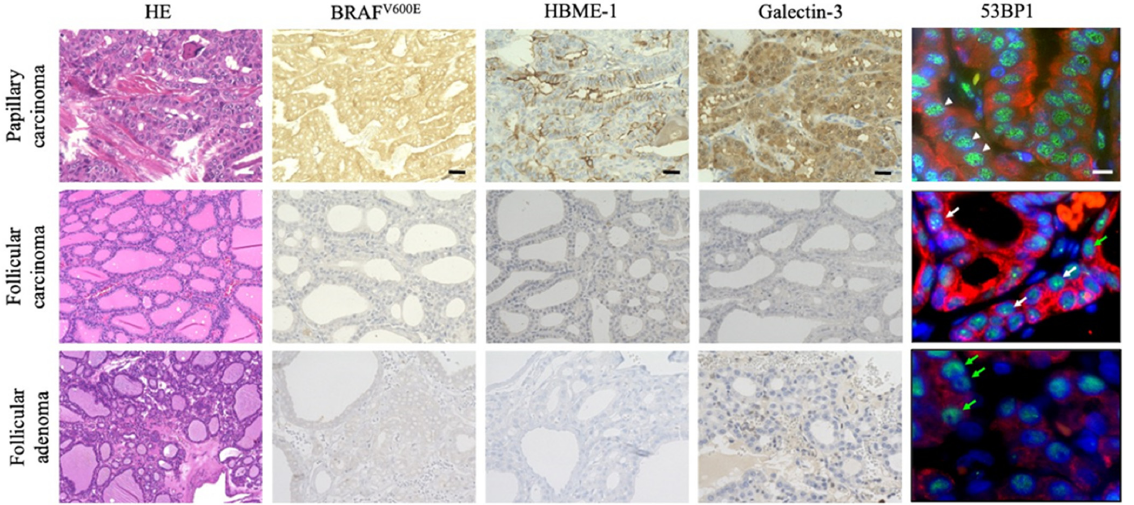
Figure 2. Immunohistochemistry (IHC) of biomarkers for papillary thyroid carcinoma (PTC), such as BRAF V600E , Hector Battifora mesothelial epitope (HBME)-1, and galectin-3 expression, and double immunofluorescence (IF) for p53-binding protein 1 (53BP1) (green) and pan-cytokeratin (AE1/AE3) (red) expression to detect follicular epithelia in metastatic PTC and thyroid follicular inclusions (TFIs) in cervical lymph nodes. All three biomarkers for PTC were positive in metastatic PTC and not in other TFIs without PTC-like nuclear features (NFs). In IF, the arrowheads and white and green arrows indicate the diffuse, DDR, and stable types of 53BP1 expression, respectively. The scale bars indicate 30 µm and 10 µm in HE/IHC and IF, respectively.